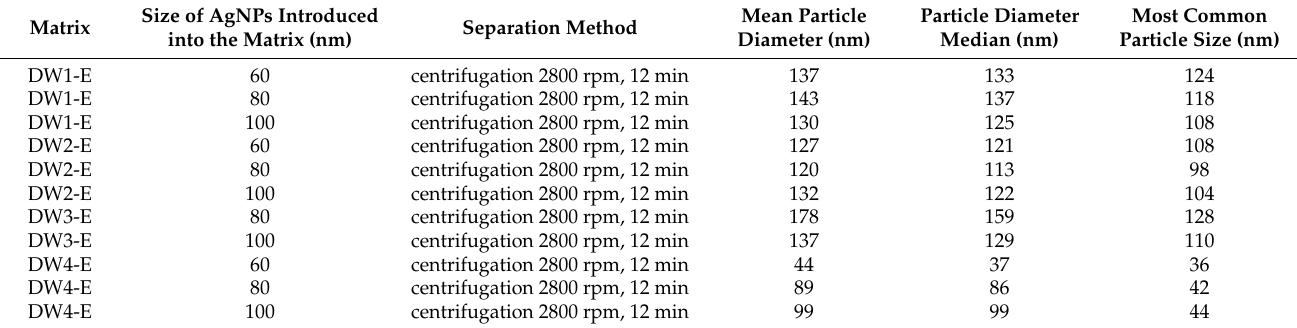
Table 7. AgNP separation results for drilling waste extract samples DW(1–4)-E enriched with AgNPs after centrifugation at 2800 rpm for 12 min. Three different sizes of AgNPs were introduced into the drilling waste matrix, 60, 80, and 100 nm. The table shows mean particle diameter, particle diameter median, and most common particle size.